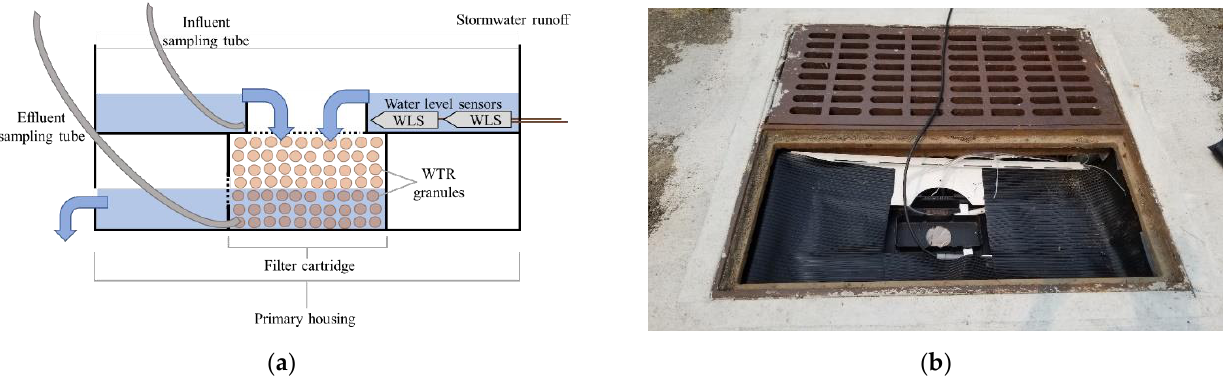
Figure 2. ( a ) Diagram of the catch basin inserts, and ( b ) catch basin insert installed in the site.